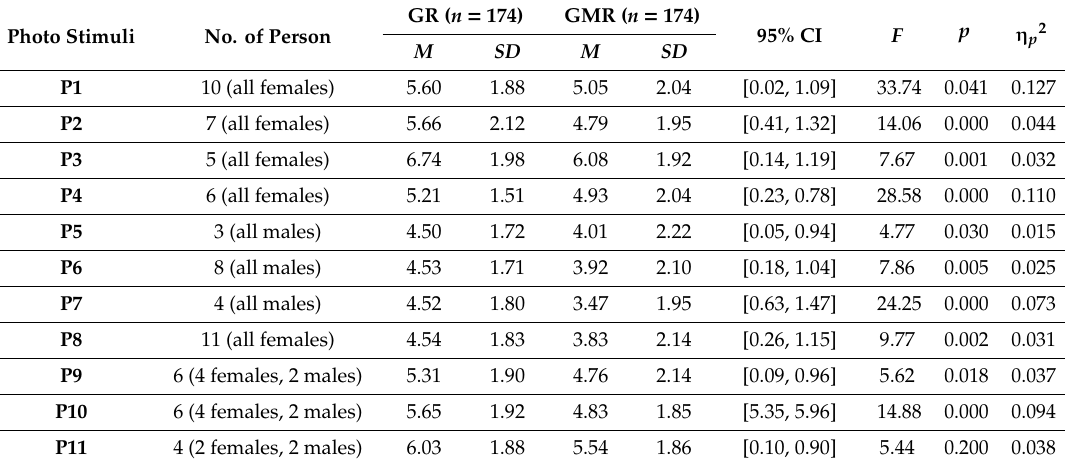
Table 2. Comparisons between the GR and GMR from Study Ib ( n =